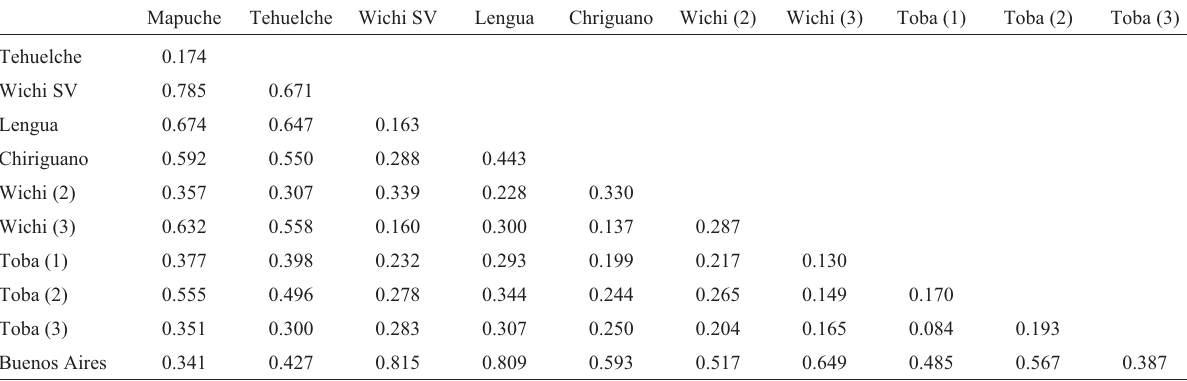
Table 4 - Genetic distances (DA) for ten populations of